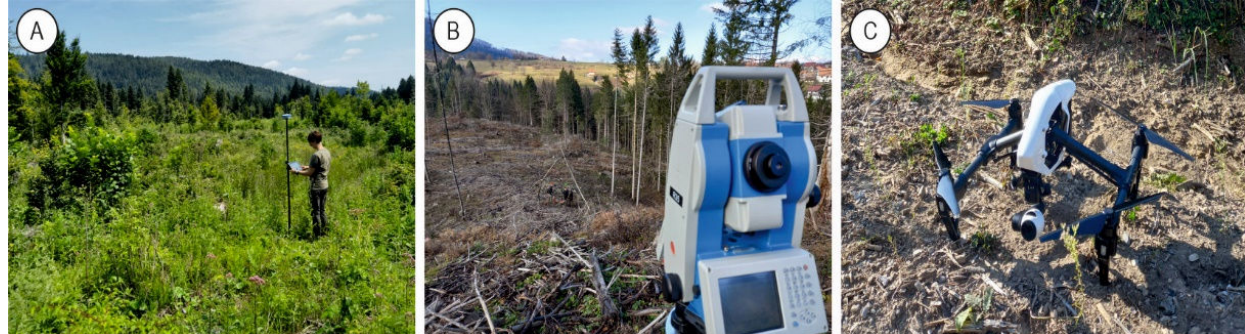
Figure 2. Equipment used in the research: ( A ) RTK GNSS STONEX S900A terrestrial receiver, ( B ) STONEX TS R35 WINCE total station and ( C ) UAS DJI Inspire 1 V2.